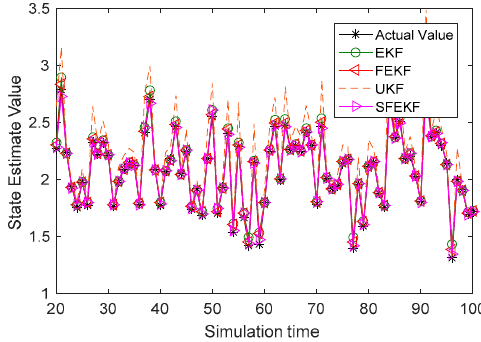
Figure 3. The estimate curves of the four methods and the actual value curve.